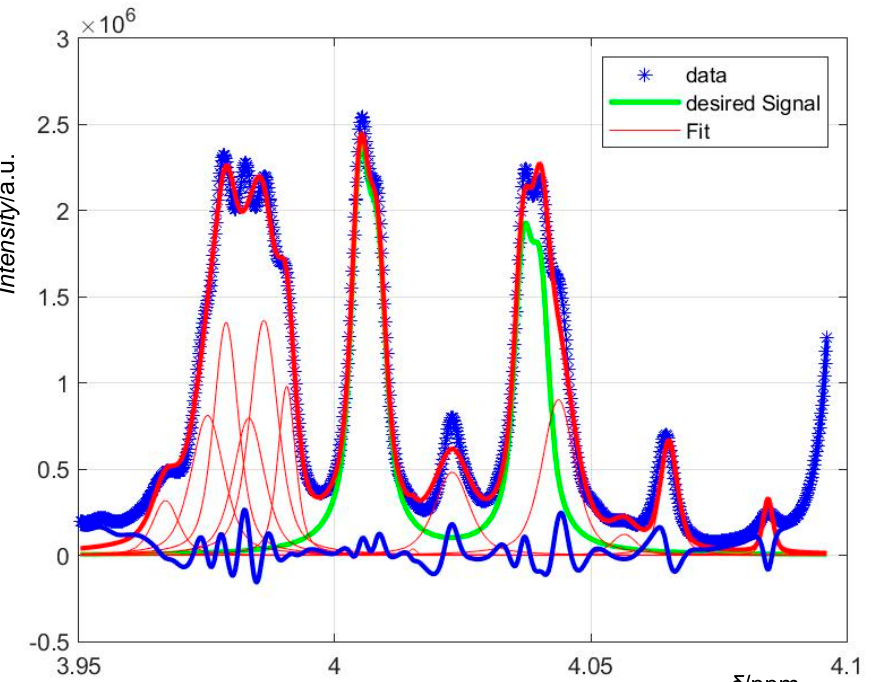
Figure 1. On demand Matlab output graphs of the curve fits, in this case the first signal of fructose. The green curve is the desired fit, the sum of four pseudo-Voigt profiles with the constraints typical for this signal. To mimic the curve of the original data (blue asterisks), Matlab adds more singlet profiles (thin red lines), all combined yield the thick red line. The residues are shown as a thick blue line.